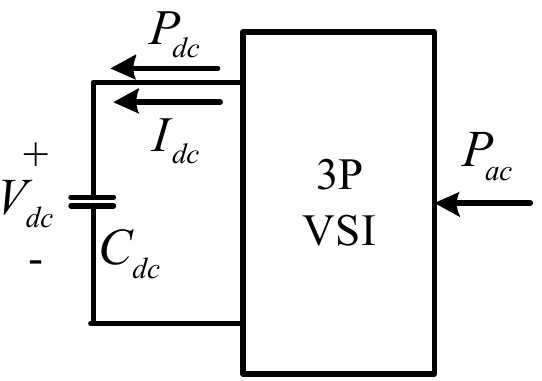
Figure 6. Bode plot of the two inductor current control loops.